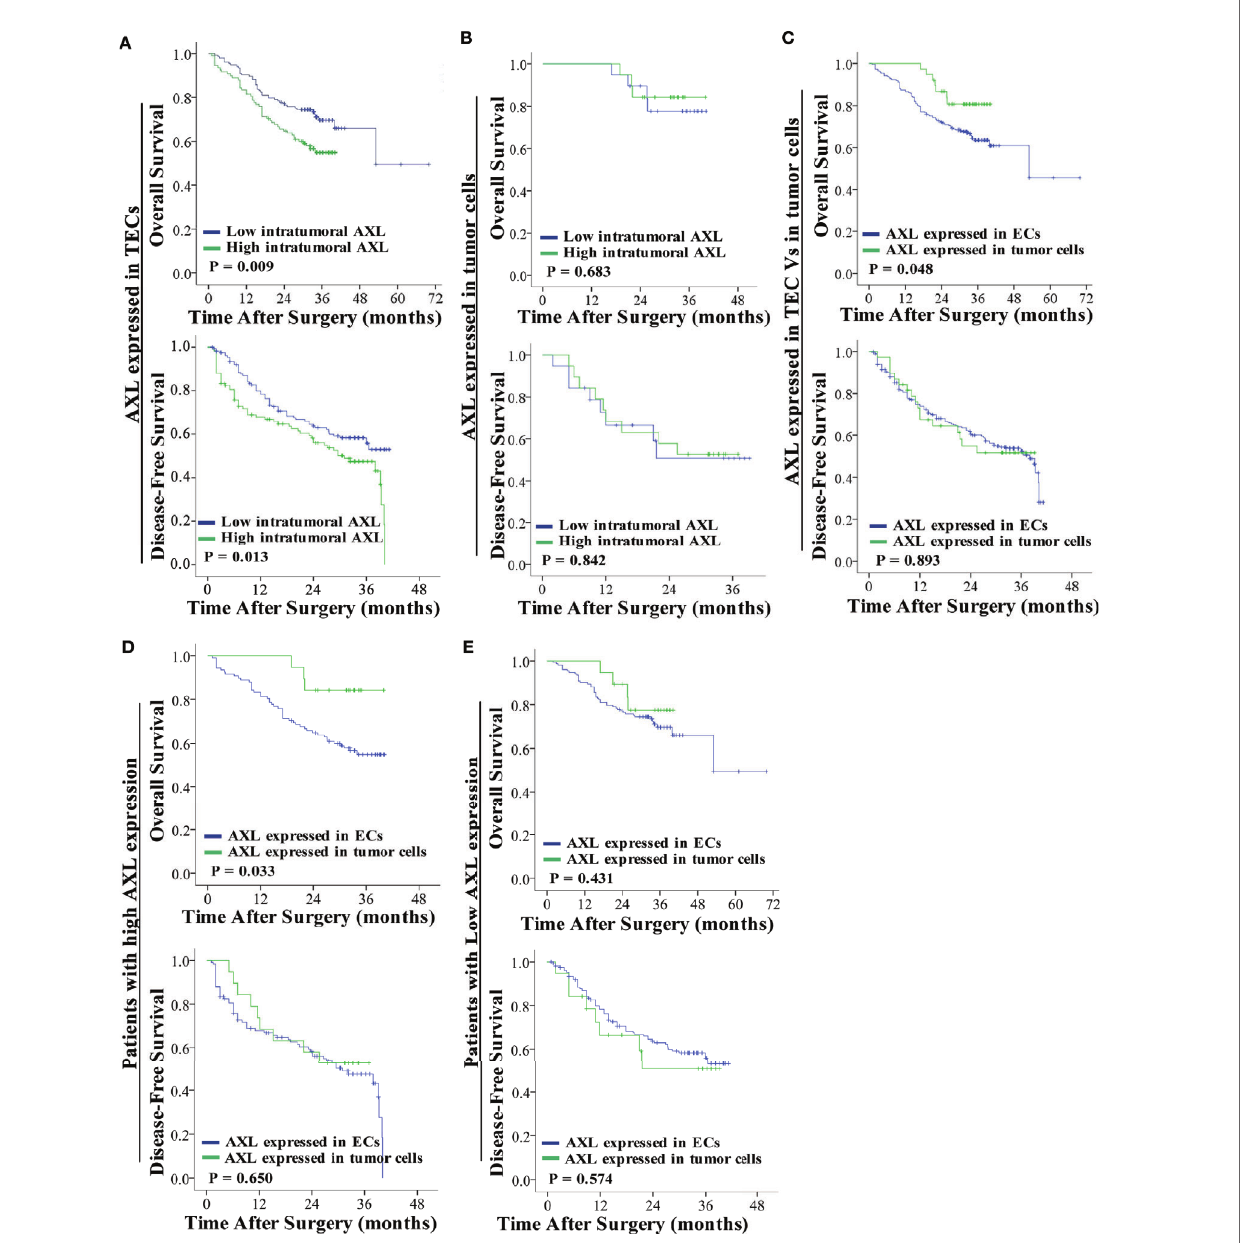
FIGURE 2 | AXL overexpression in TECs but not tumor cells indicates poor prognosis. (A) Low expression of AXL in TECs was associated with prolonged survival (OS: p = 0.009; DFS: p = 0.013). (B) AXL overexpression in tumor cells indicated no signi fi cant association with poor prognosis. (C) AXL expressed in TECs was associated with lower OS compared with AXL expressed in TCs. (D) High expression of AXL in TECs indicated poorer survival compared with high expression of AXL in TCs (OS: p = 0.033; DFS: p =0.650). (E) There was no signi fi cant difference in survival between patients with low expression of AXL in TECs and patients with low expression of AXL in TCs (OS: p = 0.431; DFS: p